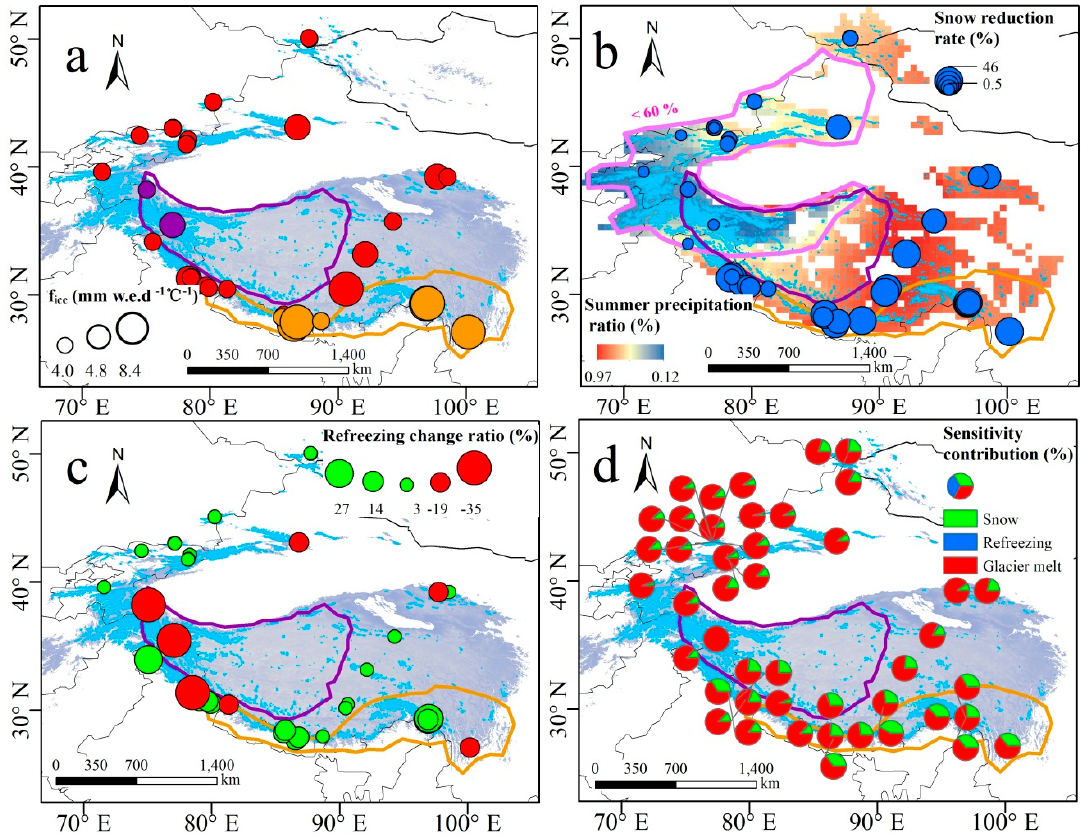
Figure 9. Spatial distribution of factors influencing the mass balance sensitivities: ( a ) degree day factors, ( b ) summer precipitation proportion (%) to annual precipitation (pink line encloses the area of < 60%), ( c ) change in the refreezing proportion (green circles indicate a refreezing decrease, while red circles indicate refreezing increase) under + 1 K scenario, and ( d ) contribution of snow (accumulation), refreezing, and melt (ablation) to the mass balance sensitivity under + 1 K temperature change.